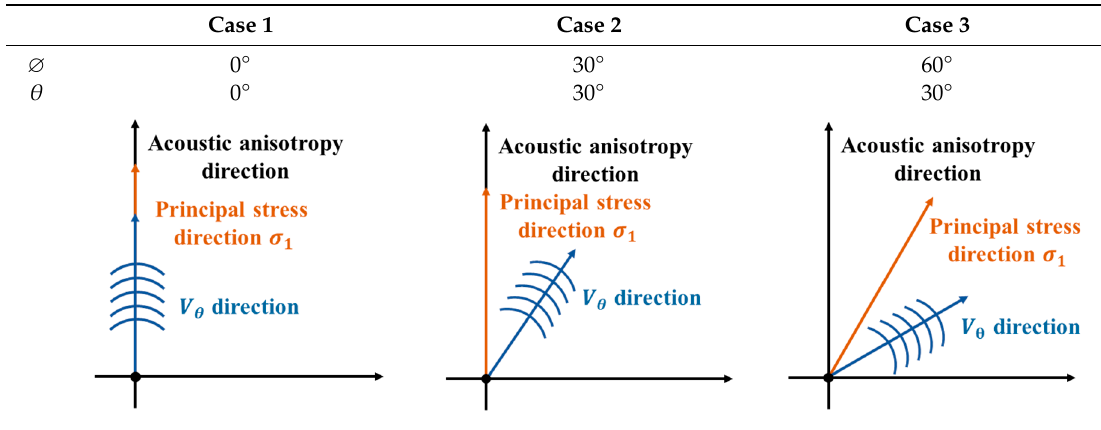
Table 1. Directions of the anisotropy, principal stress, and the surface wave propagation for numerical simulation.